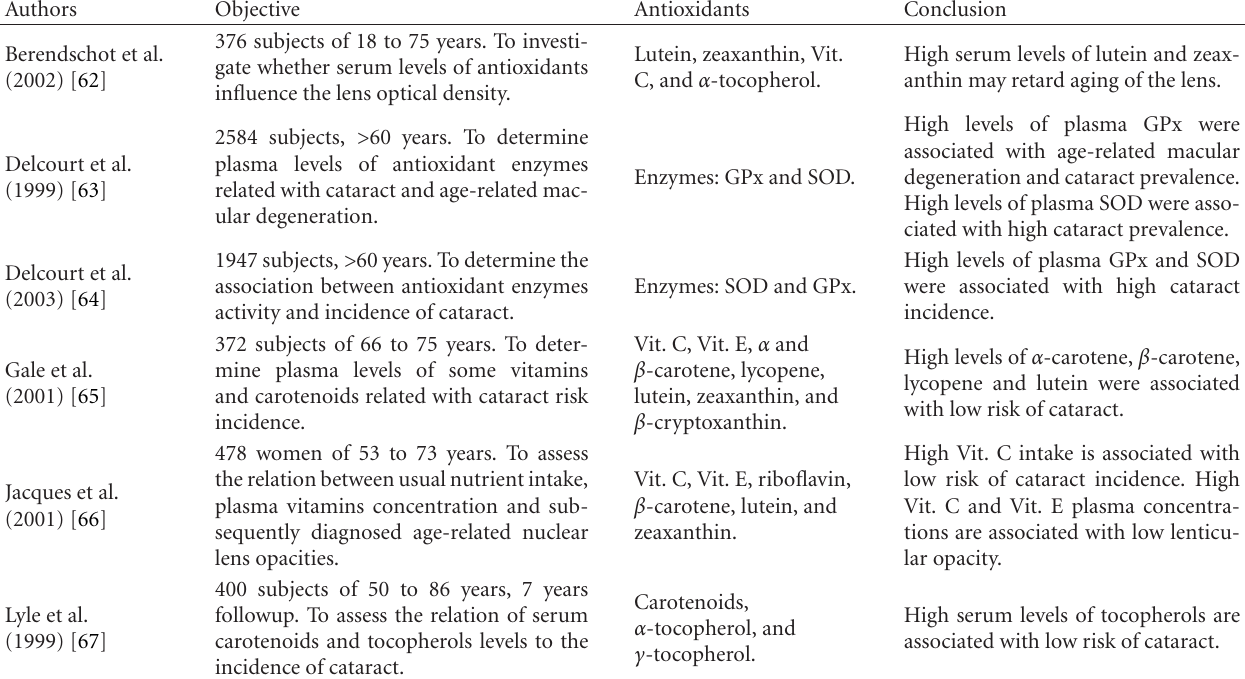
Table 1: Incidence of eye disease compared with antioxidant intake and/or plasma levels of antioxidants molecules in humans.